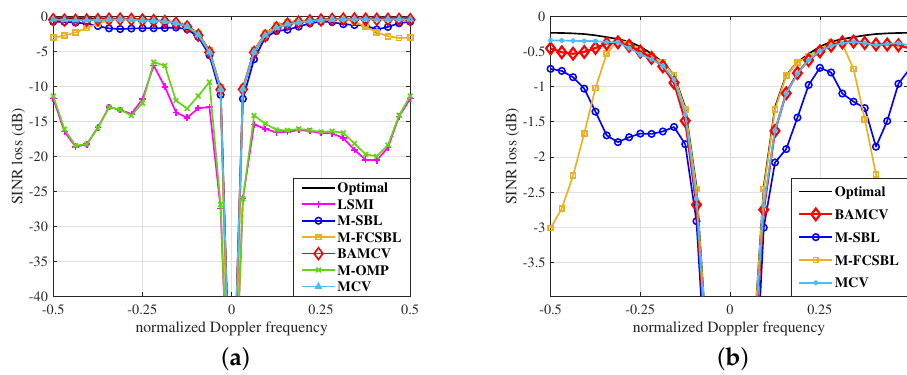
Figure 8. SINR loss curves. ( a ) SINR loss curves of all comparison methods. ( b ) SINR loss curves of Bayesian STAP methods.